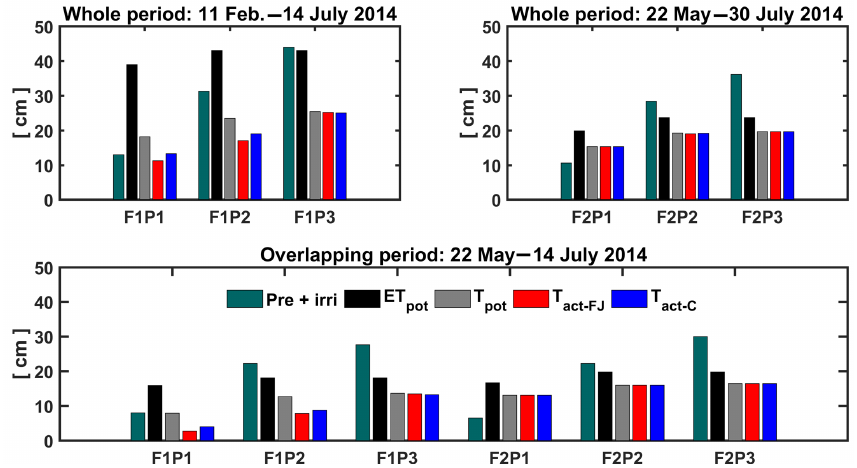
Figure 9. Potential evapotranspiration (ET pot ), potential transpiration ( T pot ), and actual transpiration ( T act = RWU) estimated by the Feddes– Jarvis (FJ) and Couvreur (C) models in the three plots (P1: sheltered; P2: rainfed; P3: irrigated) of the stony (F1) and silty (F2) soils in the whole period and in the overlapping period. Pre: precipitation; irri: irrigation.